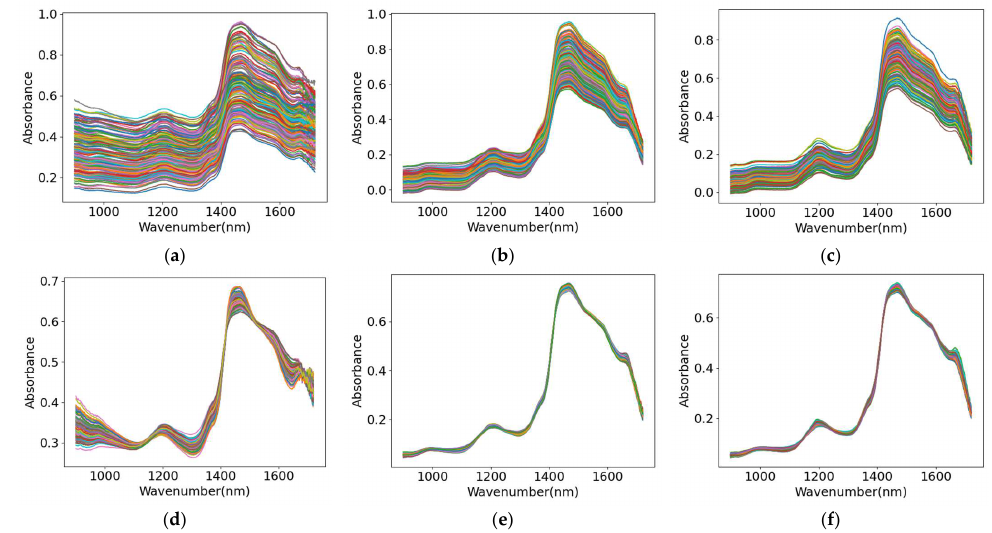
Figure 9. WT + MSC for spectral preprocessing of three coniferous wood: ( a ) Raw spectrum for larch; ( b ) Raw spectrum for hemlock; ( c ) Raw spectrum for mongolica; ( d ) Preprocessed spectrum for